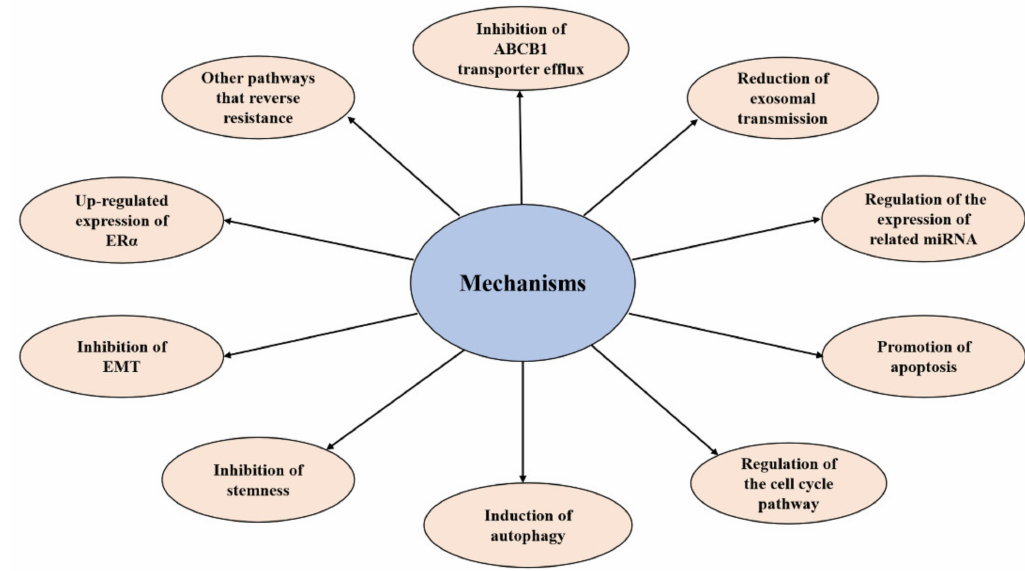
Figure 3. Classification of multidrug resistance mechanism of tumor cells reversed by elemene.